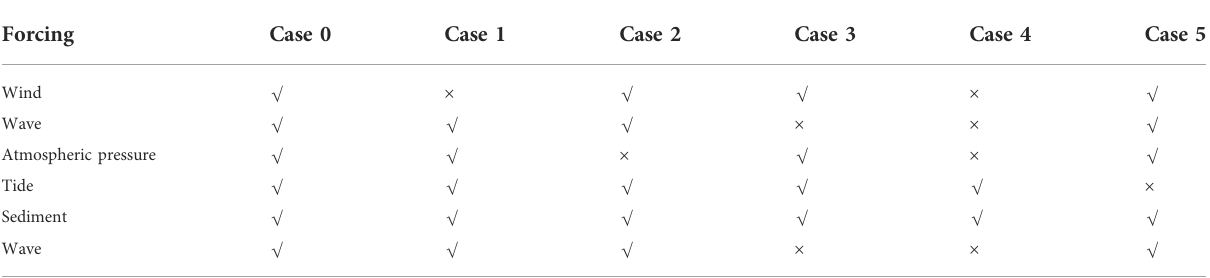
TABLE 3 Forcings considered in the numeric